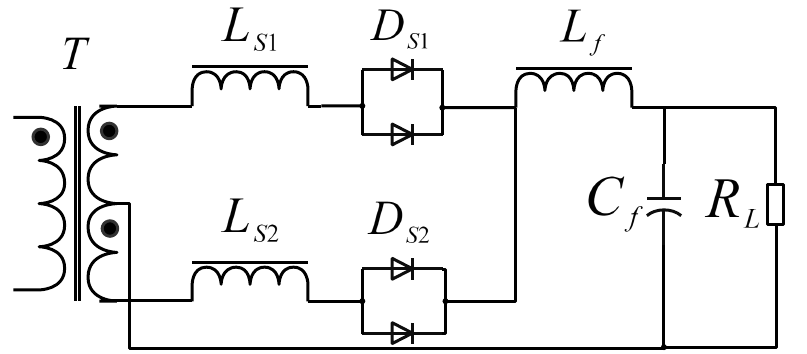
Figure 3. The secondary circuit of ZVS-HBPS-LVHC-SI.